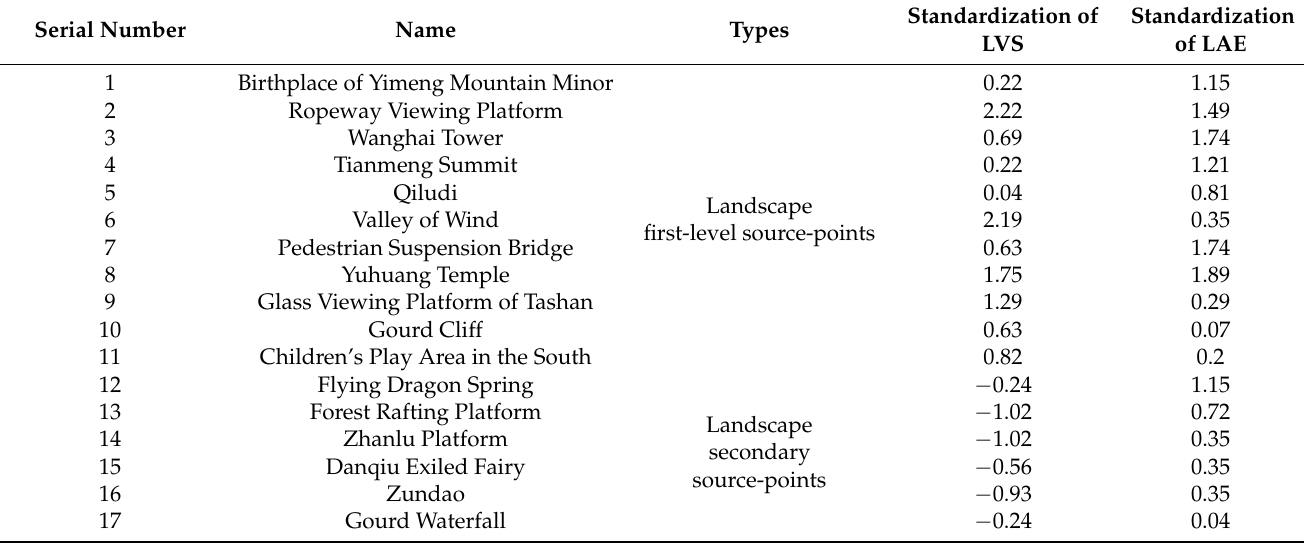
Table 9. Information about high-quality landscape